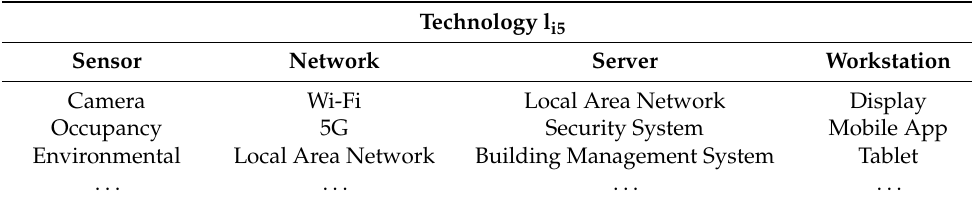
Table 6. Asset Omni-management